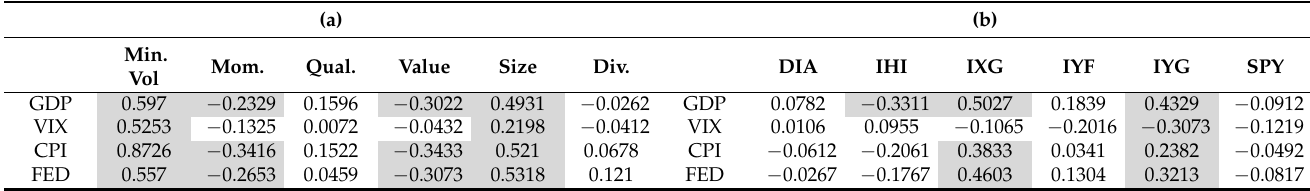
Table A7. Correlation between optimal weights of smart beta (a) and ETFs (b) and macroeconomic variables for α = 0. Significant correlations (5% significant level) are highlighted by gray color.